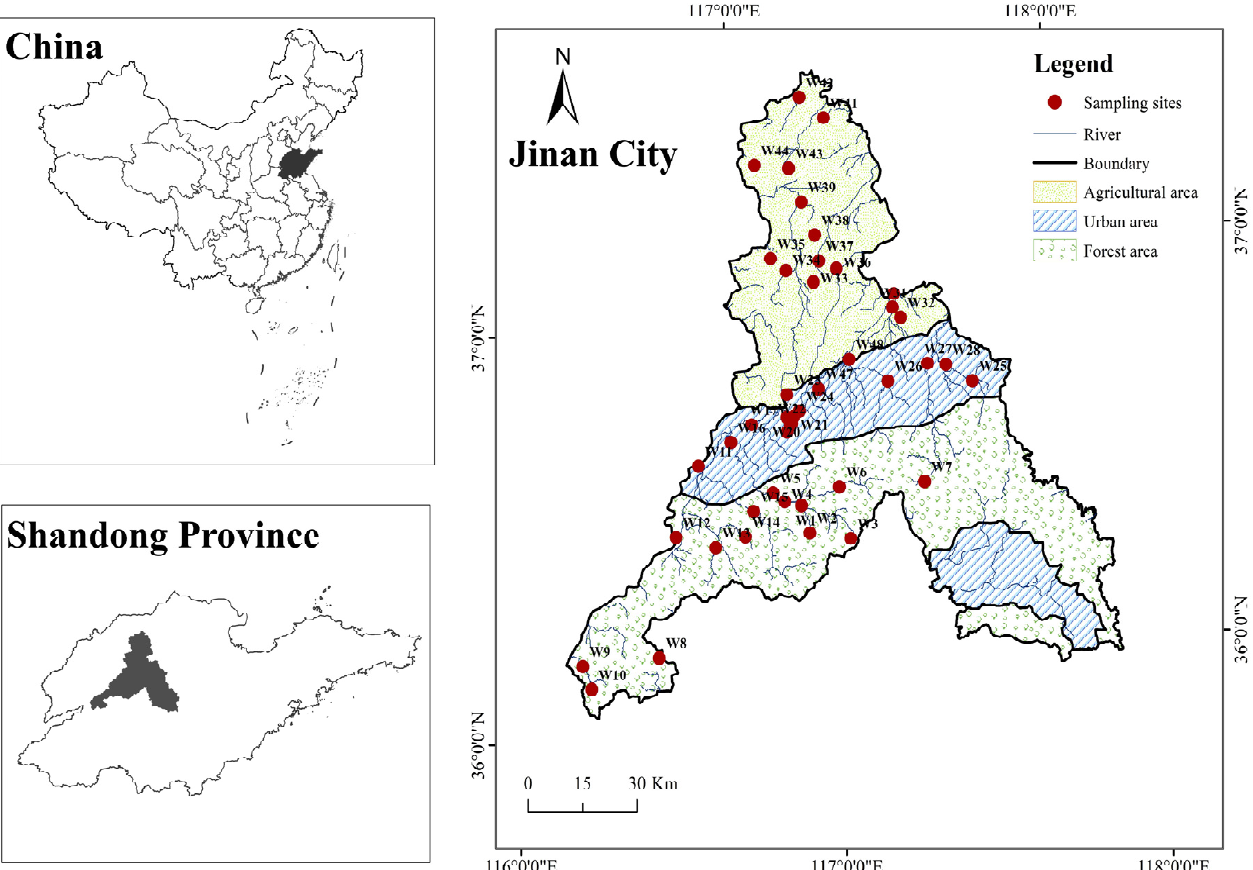
Figure 1. The distribution of 44 sampling sites in Jinan, Shandong Province, China.